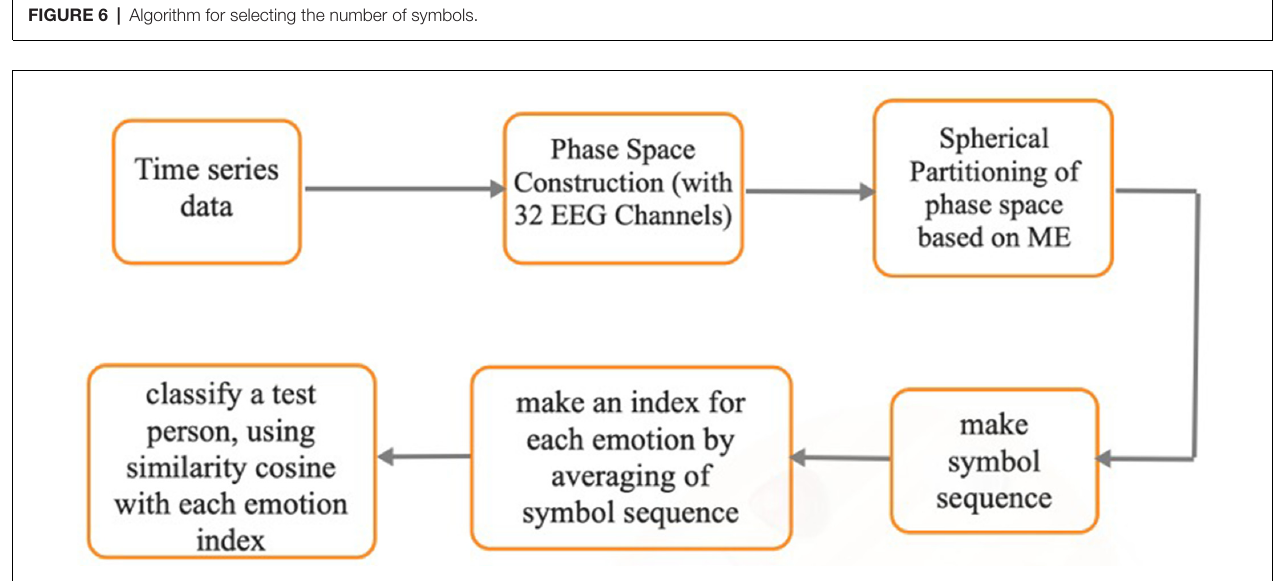
FIGURE 6 | Algorithm for selecting the number of symbols.